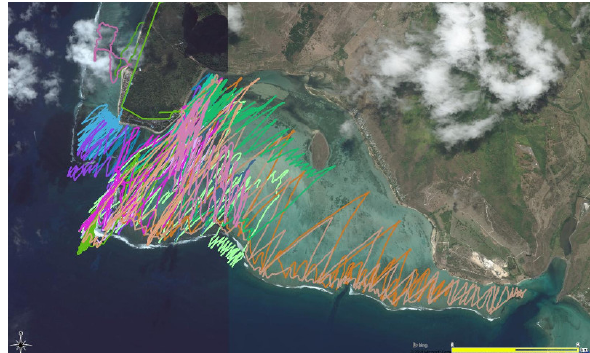
Figure 4. Location of all pictures collected in Le Morne lagoon